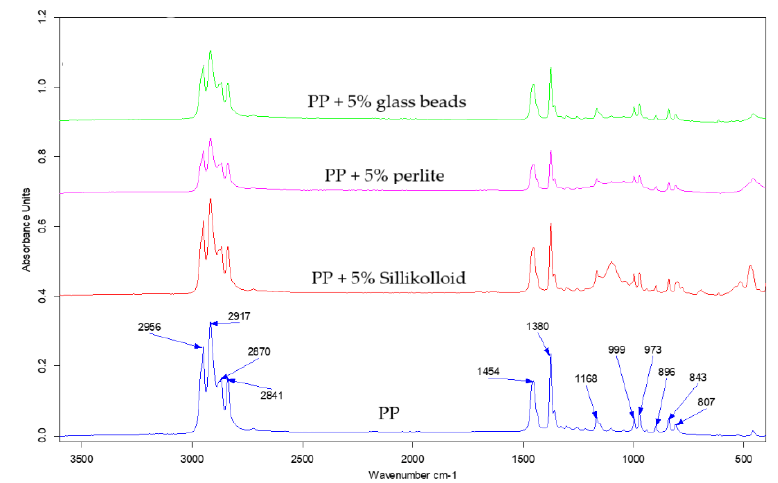
Figure 4. Attenuated total reflectance-Fourier transform infrared spectroscopy (ATR-FTIR) spectra of the unoriented i -PP ( blue ), i -PP + 5% of Sillikolloid ( red ), i -PP + 5% of perlite ( pink ), and i - PP + 5% of glass beads ( green ).